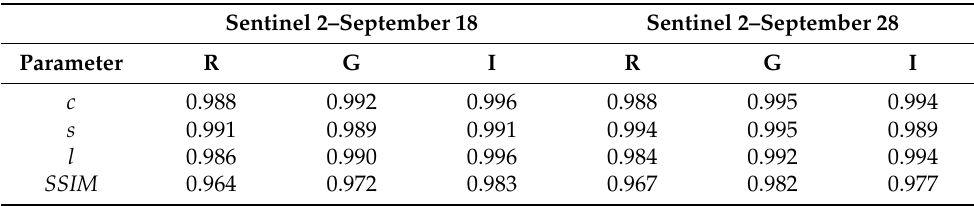
Table 5. Similarity of the Sentinel 2 images during the overlapping period. Reference: September 3